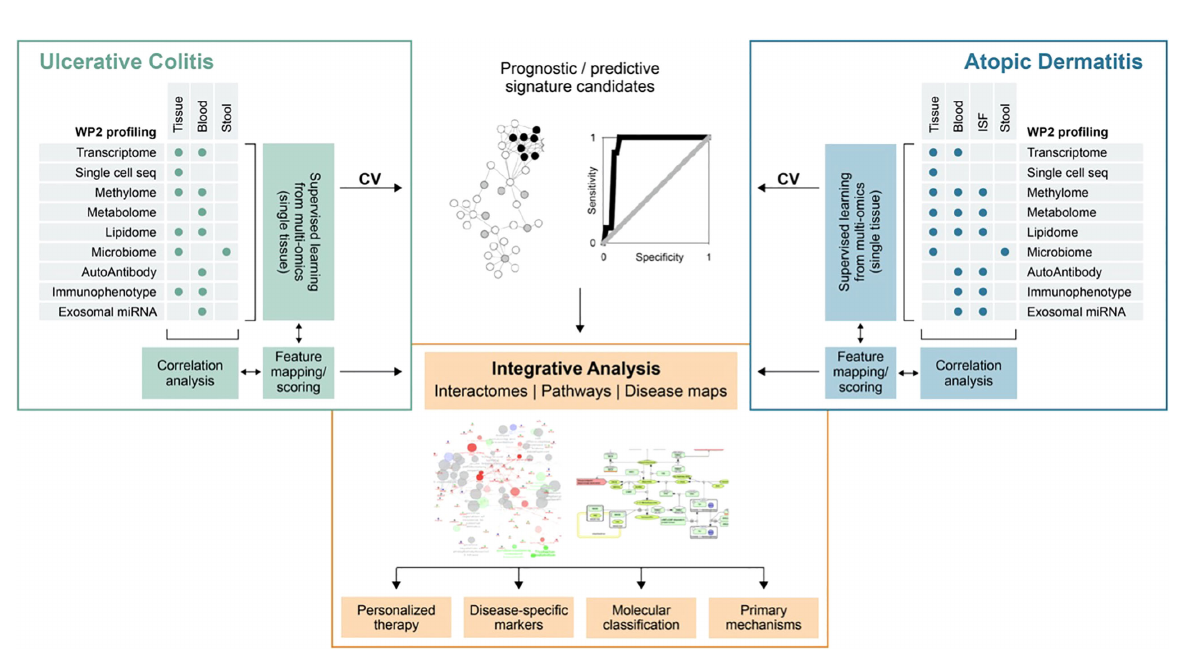
FIGURE 1 Schematic diagram of ImmUniverse data integration strategy. Ulcerative colitis and atopic dermatitis will be analyzed separately according to the same principle: First, supervised multi-omics analysis will be performed to identify candidate prognostic and predictive signatures from multi- omics analysis of single tissue data and evaluate their performance in cross-validation (CV) or through publicly available data (as available). Signatures will be then correlated between sample matrices to identify ‘ proxy ’ – signatures in matrices suitable for clinical exploitation. Features from prediction and correlation tasks will be pooled, mapped to pathways and ontologies and prioritized on the basis of their importance for prediction, across-tissue correlation and pathway annotation in a collaborative effort between project partners (clinicians, biologists and bioinformaticians). Comparison between UC and AD will be done subsequently on the basis of shared and speci fi c pathways and ontologies. From these, interaction networks and disease maps will be generated to describe the overlapping and unique processes in the relevant tissue types. ISF, interstitial fl